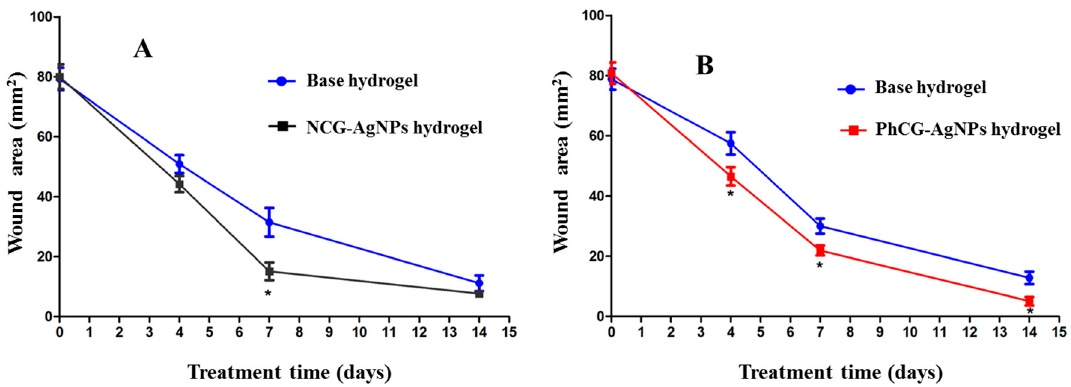
Figure 9. Relation between the time of action of the NCG-AgNPs ( A ) and PhCG-AgNPs ( B ) hydrogels and the wound area in rats. * p < 0.05 statistical significance.